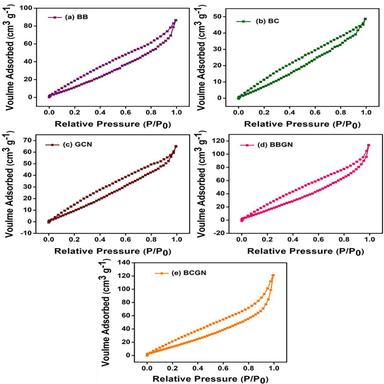
BET analysis of (a) BB, (b) BC, (c) GCN, (d) BBGN and (e) BCGN nanocomposites.